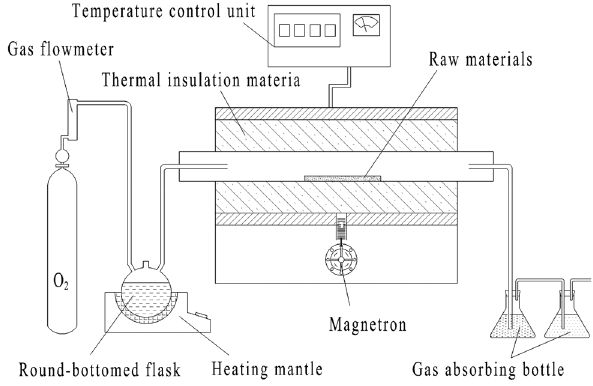
Fig. 2: Schematic of the microwave reactor